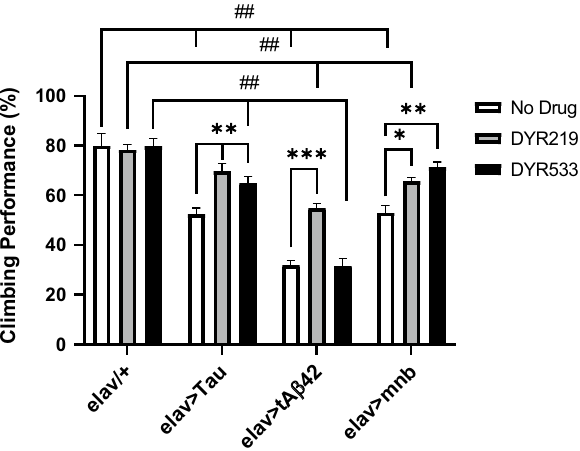
Figure 4. Pan-neuronal overexpression of human Tau, amyloid-β42 and mnb cause movement deficits suppressed by DYRK1A inhibitors. Without drug (white bars) pan-neuronal overexpression of human Tau 0N4R, tAβ42 and mnb decreased locomotion compared to control ( elav-Gal4/ +). Treatment with DYR219 DYRK1A inhibitor (grey bars) caused an increase in performance of all models, resulting in complete pharmacological rescue of human Tau overexpressing flies to control levels. DYR219 treatment significantly enhanced the climbing performance of all three degenerative mutants. Similarly, DYR533 treatment (black bars) significantly increased climbing performance of human Tau and mnb overexpressing flies fully rescuing mnb flies to control levels. 2-way ANOVA with Dunnett’s multiple comparisons with * and # as listed in the